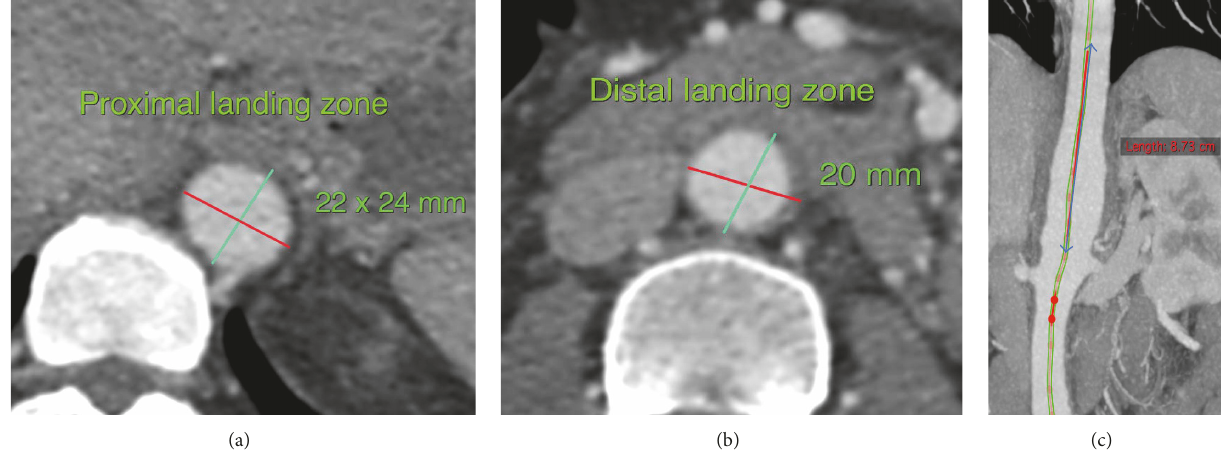
Figure 2: Proximal landing zone with diameter of 22 mm (a). Distal landing zone with diameter of 20 mm (b). Coronal view shows inflammatory and saccular aneurysm part